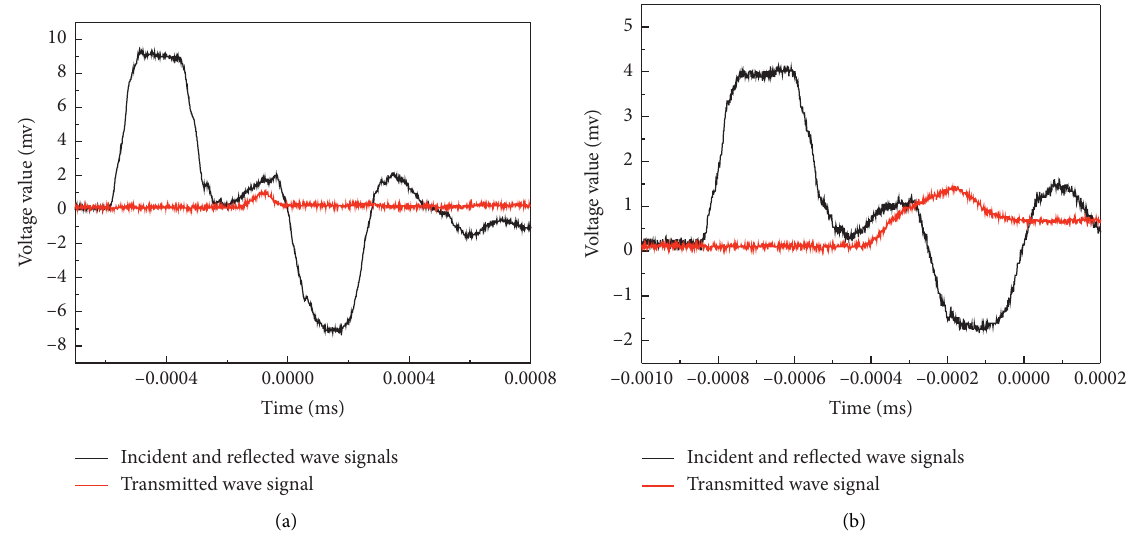
Figure 6: Typical waveform of bonding by using different adhesives. (a) Waveform of the epoxy resin AB glue. (b) Waveform of the JL-330 special rubber adhesive.